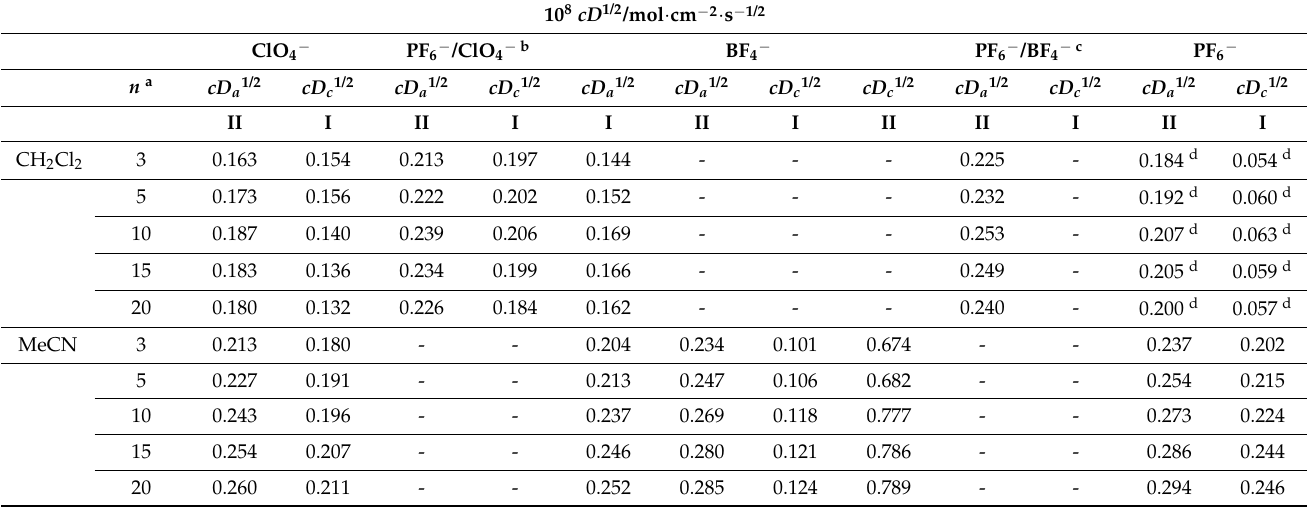
Table 3. Kinetic data for poly [Ni(salcn)] in various electrolyte solutions (10 − 1 mol · dm − 3 ) and in various